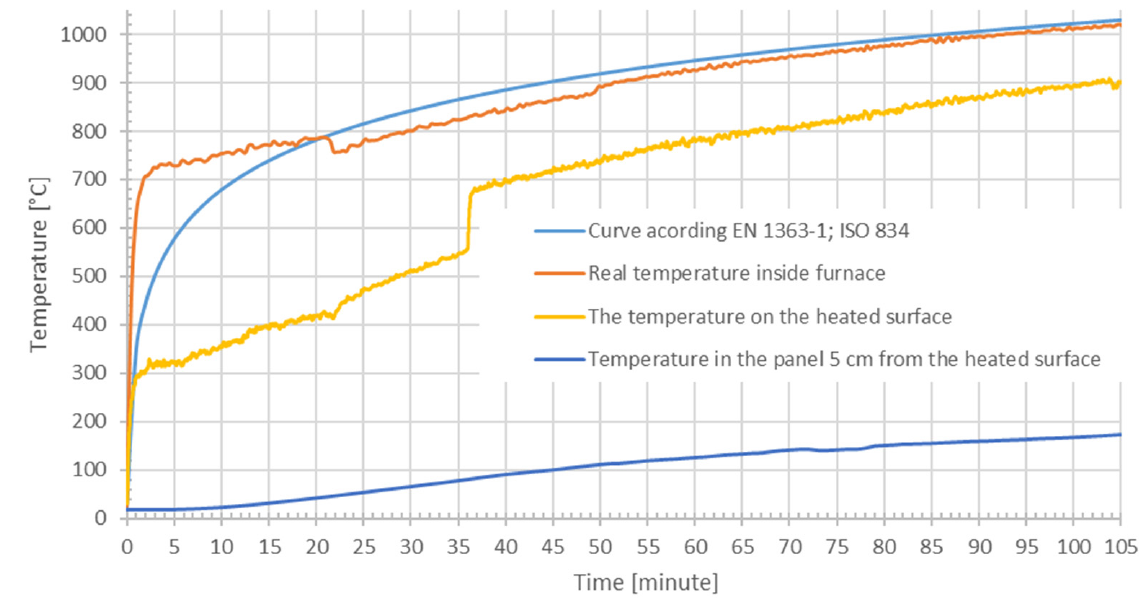
Figure 4. Temperature load and temperature course of concrete REC 2.